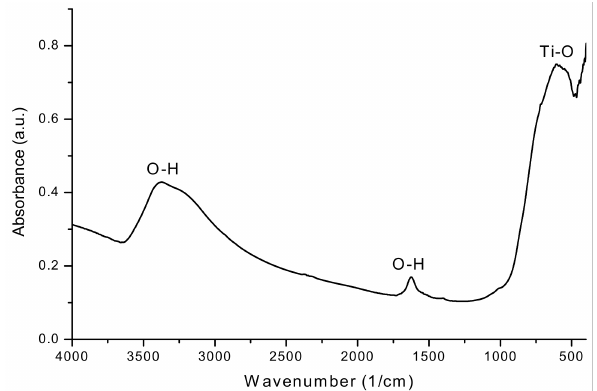
Figure 3. FT-IR spectrum of the analyzed